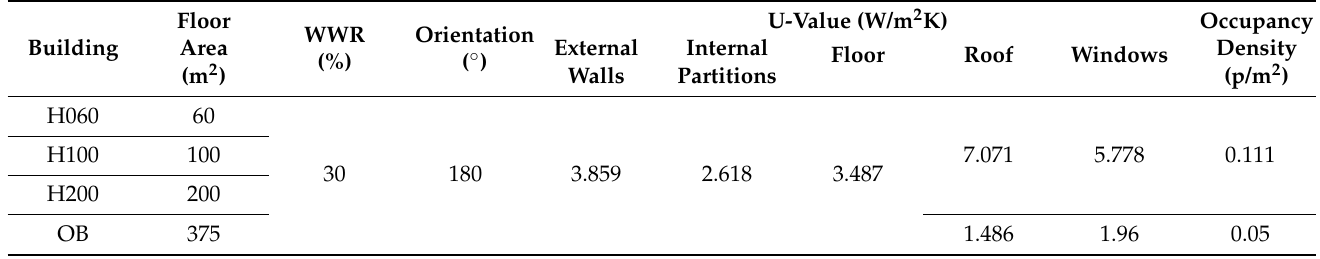
Figure 2. Four different dwellings tested: ( a ) 60 m 2 , ( b ) 100 m 2 , ( c ) 200 m 2 , and ( d ) 375 m 2 office building. Table 1. Summary of the U-values for each envelope element in the reference